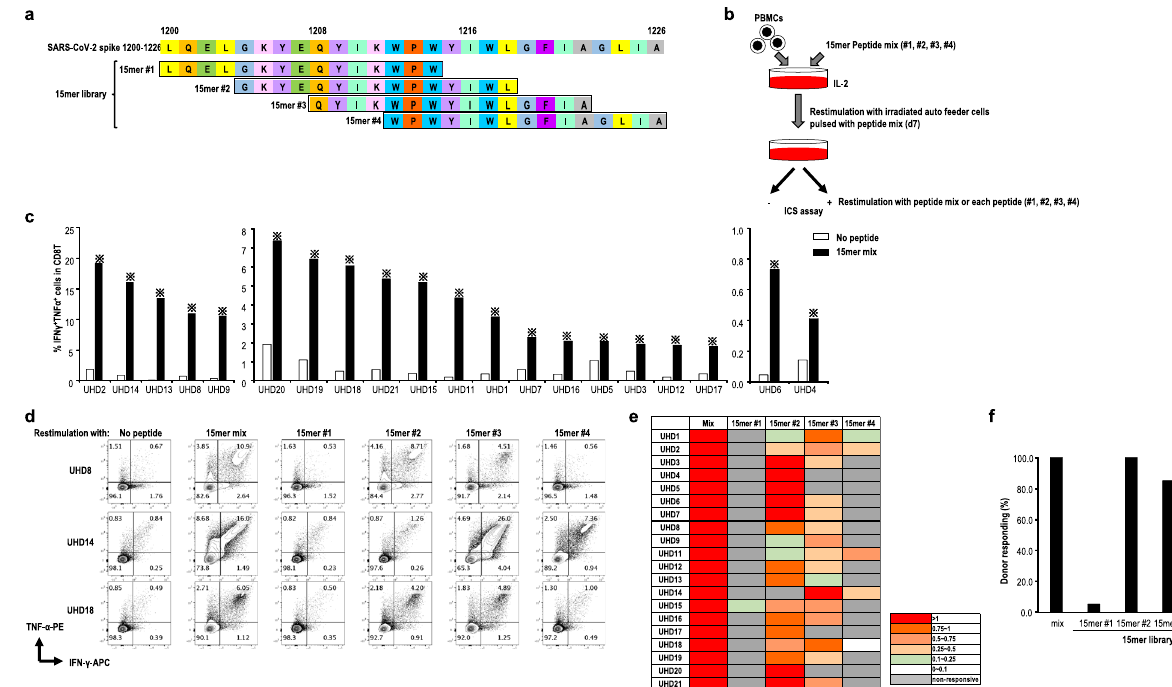
Fig. 3 Design of the 15-mer peptide mix-responding CD8 + T cells. a Design of 15-mer peptide library, including Pep#3(QYI) epitopes, in the S2 region of SARS-CoV-2. b Analysis of the 15-mer peptide-responding CD8 + T cells. PBMCs from UHDs were cultured in the presence of a 15-mer peptide mix. Two weeks later, the cultured cells were restimulated with or without the peptide mix for 16h in the presence of monensin and brefeldin. The frequency of IFN- γ + TNF- α + CD8 + T cells was measured after gating the CD8 + T cells by an ICS assay at day 14. c Data show the frequency of IFN- γ + TNF- α + CD8 + T cell response to the 15-mer peptide mix in UHDs ( n = 20). ※ responder (>1.5 fold change (restimulation + /restimulation − ). d As shown in ( b ), the cultured cells were restimulated with or without the peptide mix or each 15-mer peptide for 16h in the presence of monensin and brefeldin. The frequency of IFN- γ + TNF- α + CD8 + T cells was measured after gating the CD8 + T cells by an ICS assay. Flow cytometry data from representative donors. e Summary of the 15-mer peptide-responding CD8 + T cells. The peptide-speci fi c CD8 + T cell frequency was calculated by subtracting the frequency of IFN- γ + TNF- α + CD8 + T cells cultured without peptide restimulation (CD8T (pep − )) from the frequency of IFN- γ + TNF- α + CD8 + T cells cultured with peptide restimulation (CD8T (pep + )). Data indicate the ratio of the frequency of each 15-mer peptide-responding IFN- γ + TNF- α + CD8 + T cells to that of the 15-mer peptide mix responding IFN- γ + TNF- α + CD8 + T cells ( n = 20). f Frequency of donors responding to each 15-mer